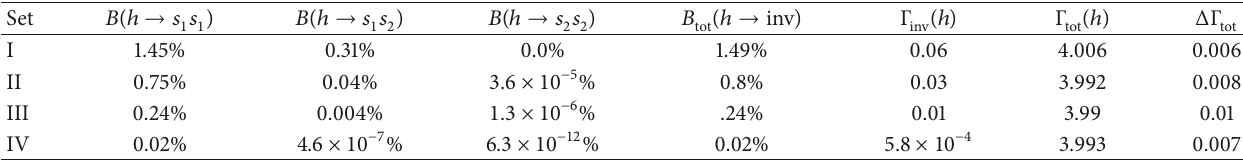
Table 2: Values of Higgs invisible branching ratios for various decay modes, total value of Higgs invisible branching ratio, Higgs invisible width, Higgs total width, and deviation of the Higgs width from the SM value are shown for various configurations. The unit for width in this table is MeV. All four configurations are consistent with current experimental